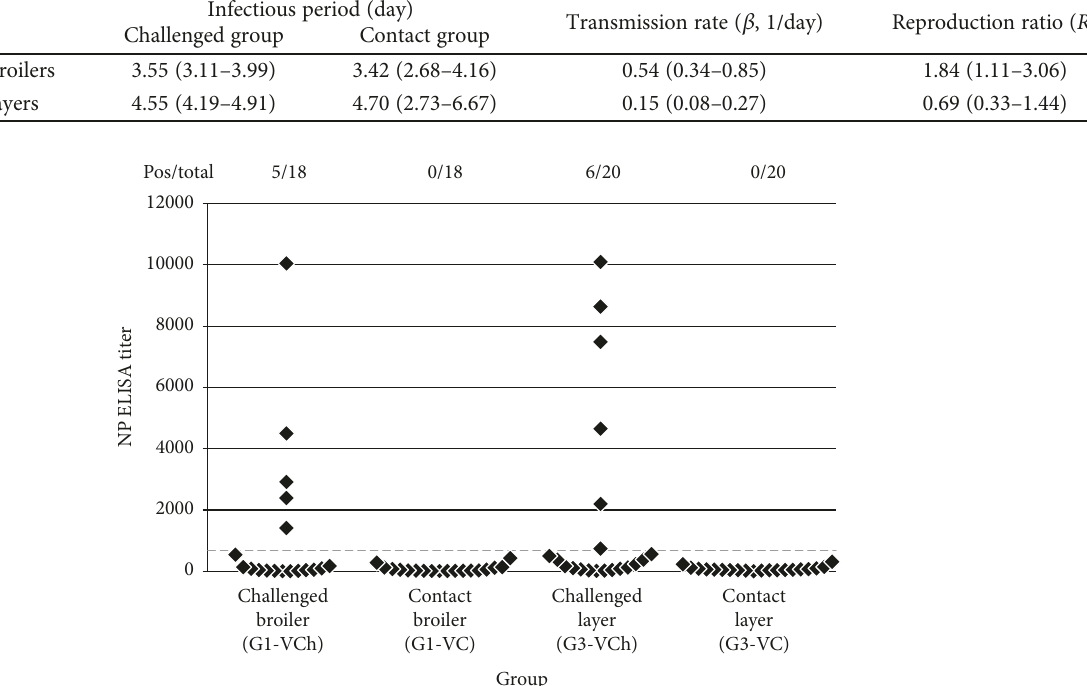
Figure 7: Presence of humoral immune response to challenge in vaccinated chickens was checked with commercial ELISA measuring antibodies against the NP protein. Positive results with ID Screen® In fl uenza A Nucleoprotein Indirect ELISA kit are above 668 titer (positivity limit is shown with dotted